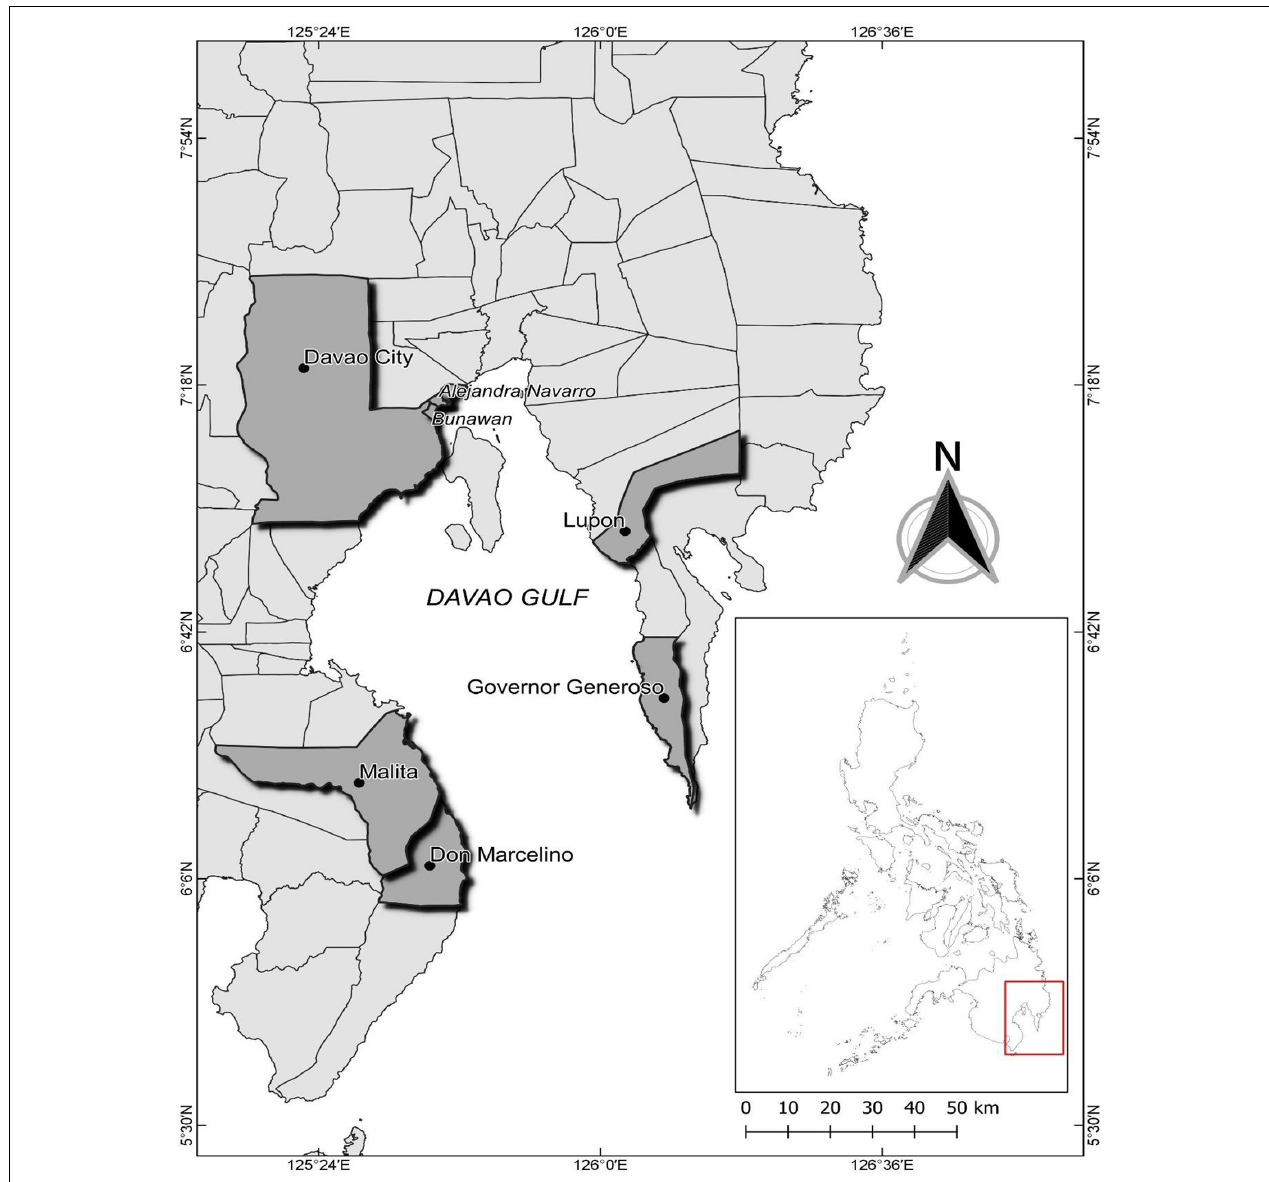
FIGURE 1 | Map of the coastal study sites (municipalities) in dark gray around the Davao